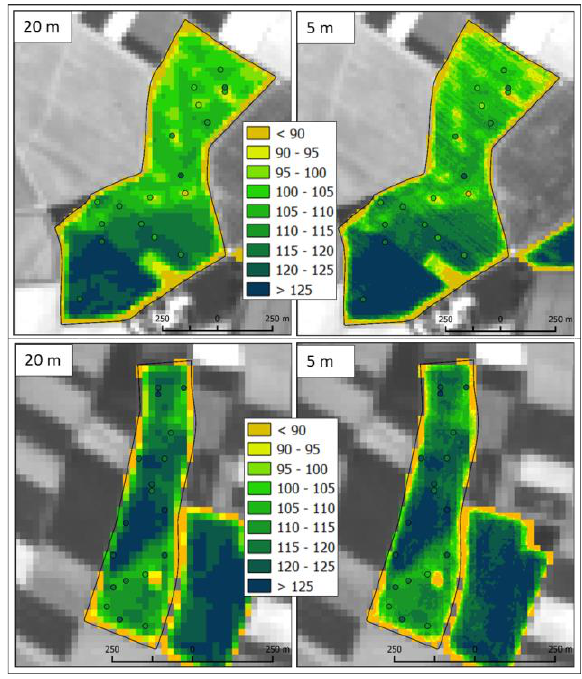
Figure 9: Results of yield modelling in 20 m (left) and 5 m (right) resolution in comparison with sample points